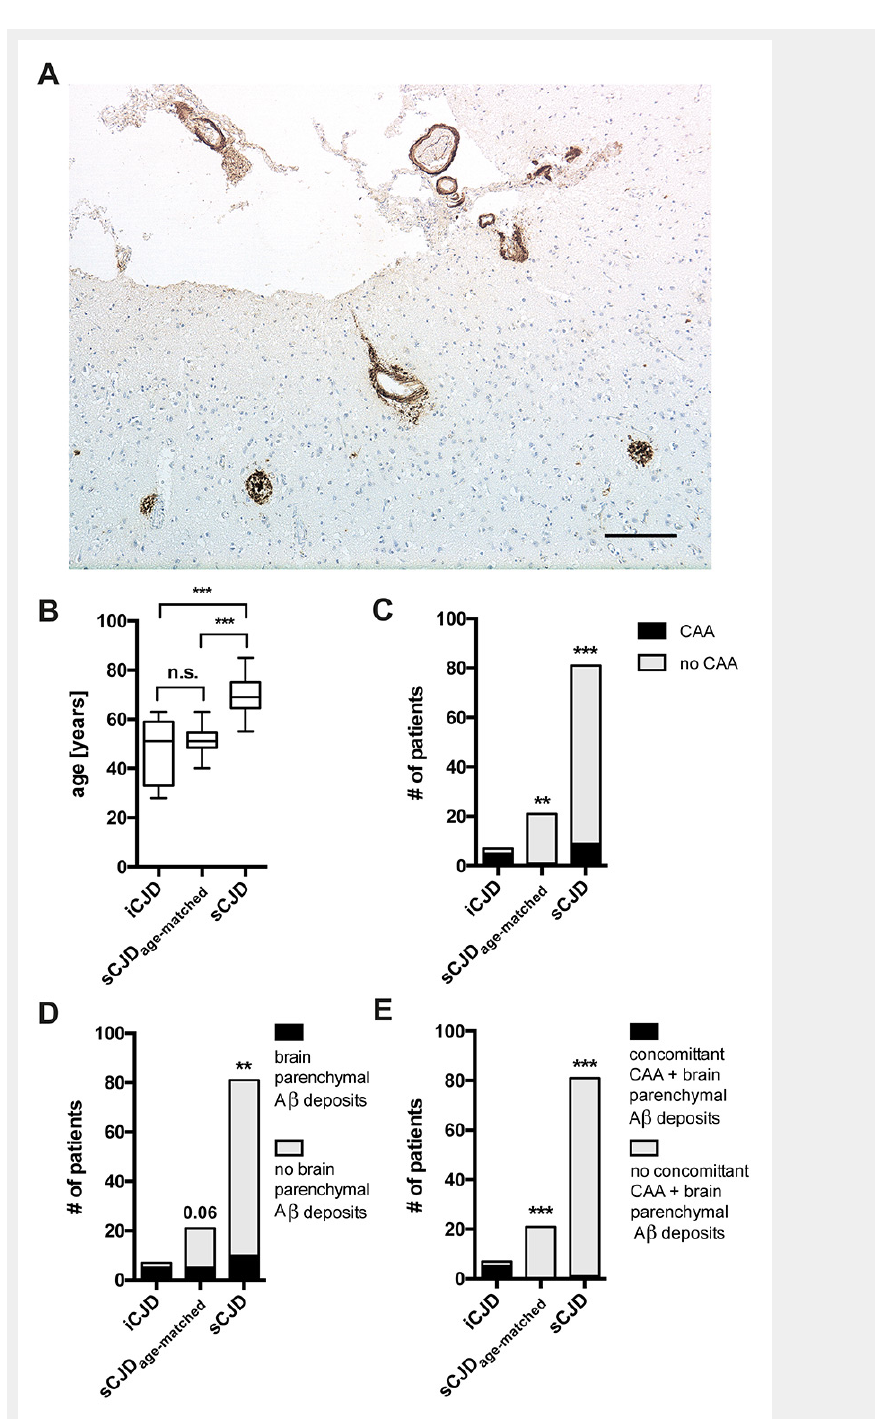
A: Immunohistochemistry for Aβ demonstrates prominent deposits (brown) in vessel walls and plaques in frontal cortex of iatrogenic CJD (iCJD) case (age 33 years). Scale bar = 200 μm. B–E: Statistical comparisons of iCJD, age-matched sporadic CJD (sCJD) and non-age-matched sCJD for age (B), cerebral amyloid angiopathy (CAA) (C), brain parenchymal deposits (D), and concomitant CAA and brain deposits (E). B: Bars are median + 25%/75% percentile (box) and min/max (whiskers). ** p <0.01, *** p